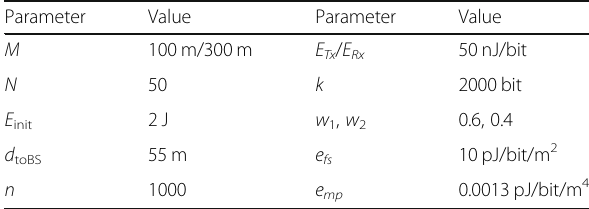
Table 2 Detailed simulation